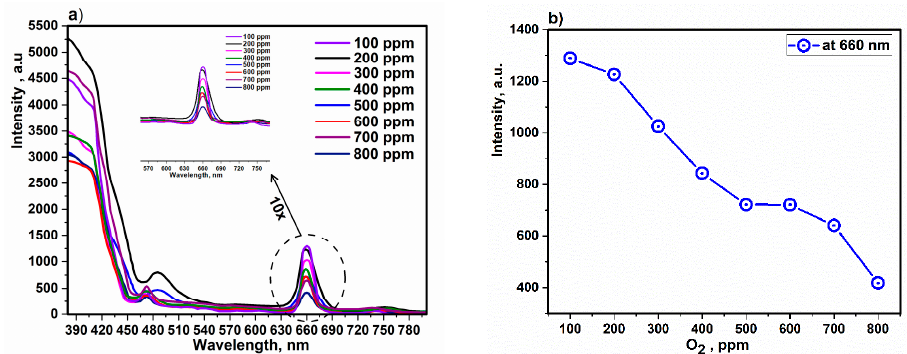
Figure 8. ( a ) PL spectra and ( b ) content of oxygen versus PL intensity of the composite in film mode.